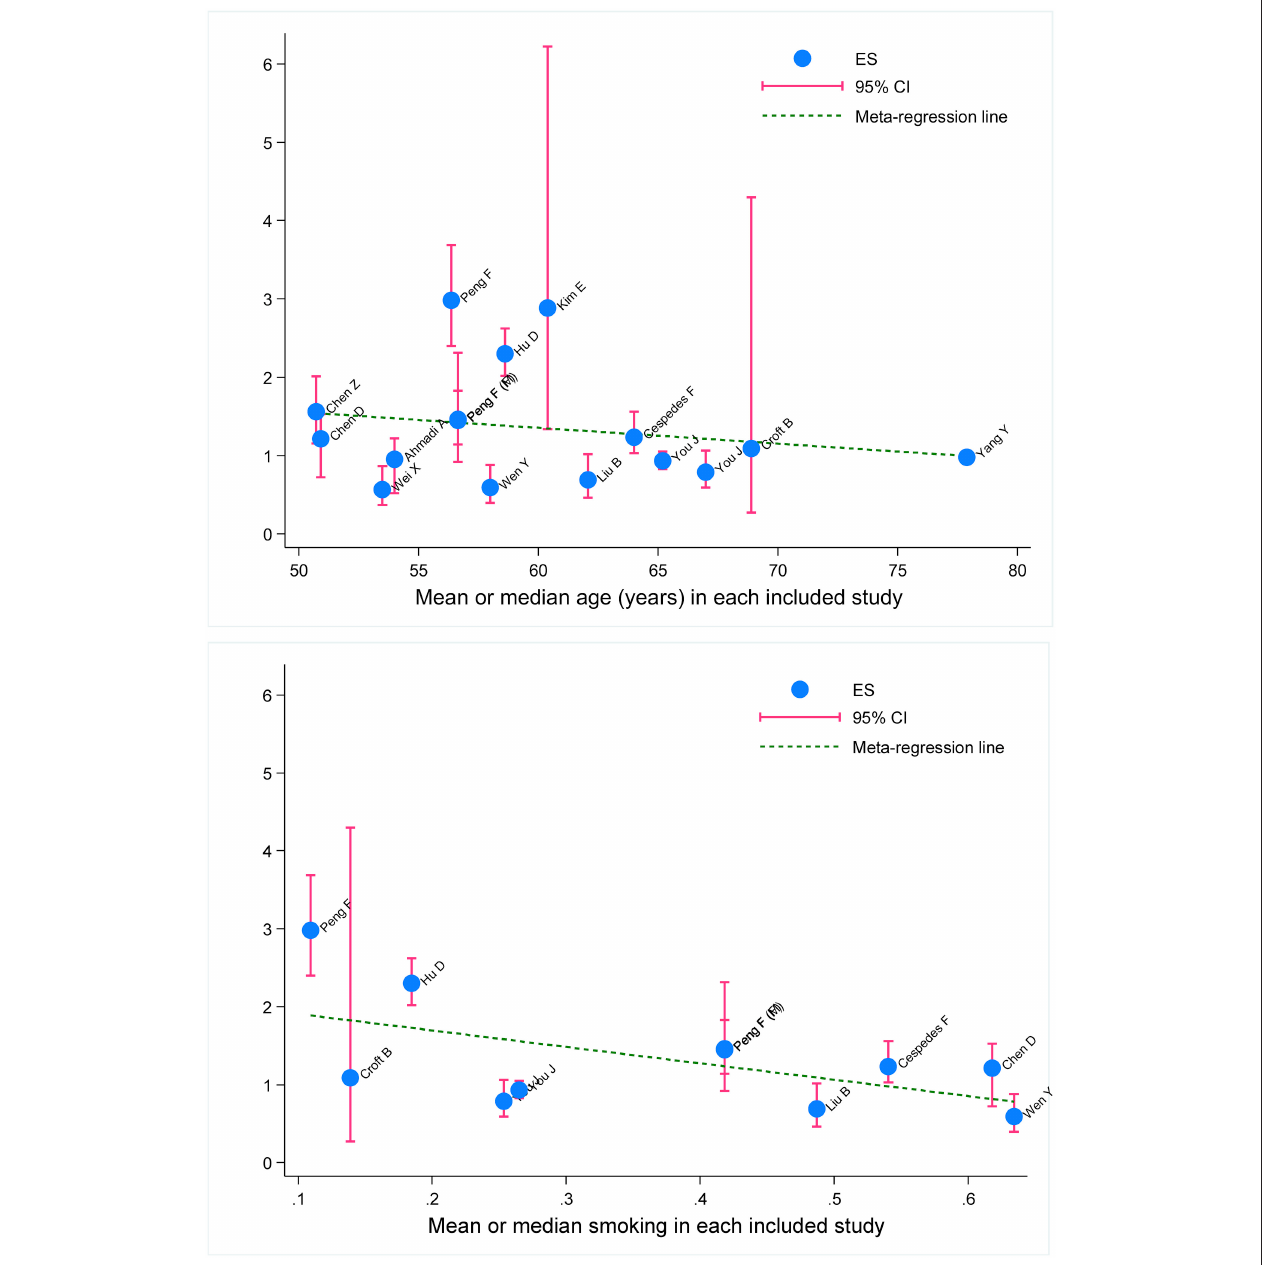
FIGURE 3 | Meta-regression of baseline age and smoking on effect size of metabolic syndrome in prediction of survival of digestive tract cancer. ES, effect size; 95% CI, 95% confidence interval. The vertical coordinate denotes effect size. The blue solid dot represents effect-size estimate, and the vertical pink line represents 95% confidence interval of study. The dotted blue line represents fitted regression line for effect-size